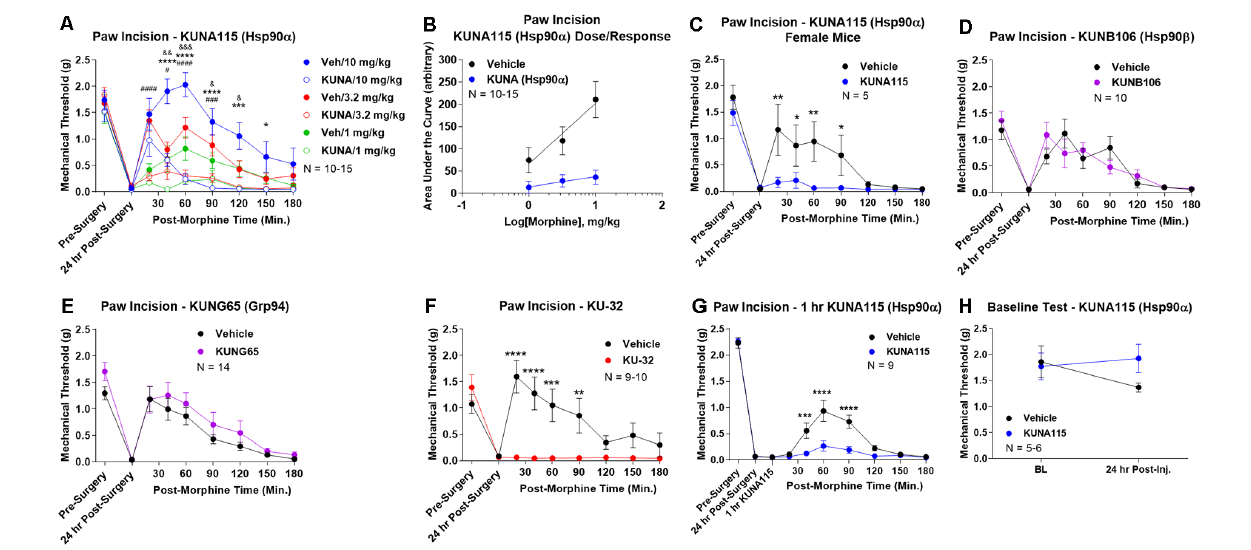
FIGURE 1 | Heat shock protein 90 (Hsp90) isoform-selective inhibitor screen identifies Hsp90 α in promoting opioid anti-nociception in the brain. CD-1 mice had the paw incision surgery performed, with concurrent injection of vehicle or 0.1 nmol of inhibitor intracerebroventricular ( icv ). Mice recovered 24 h, followed by sc injection of morphine. Mechanical thresholds measured before and after surgery, and in a time course after morphine injection. Pre- and post-surgery baselines did not differ for any group ( p > 0.05). All data reported as the mean ± SEM, with sample sizes of mice/group noted in each graph. All statistics performed by two-way